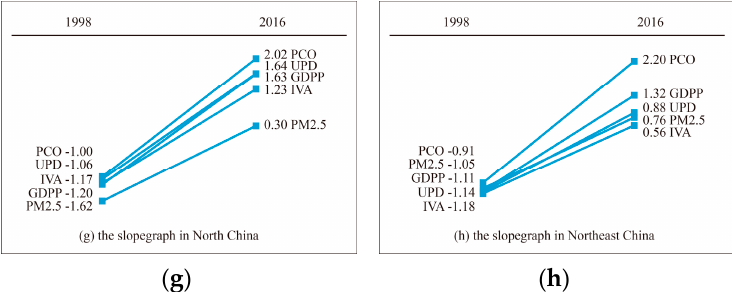
Figure 4. The slopegraph for explaining standardized annual mean PM 2.5 concentration, standardized socioeconomic factors changes 1998 vs. 2016, ( a ) the slopegraph of PM 2.5 in the seven geographical subareas, ( b ) the slopegraph of PM 2.5 and socioeconomic factors in East China, ( c ) South China, ( d ) Central China, ( e ) Northwest China, ( f ) Southwest China, ( g ) North China, and ( h ) Northeast China.